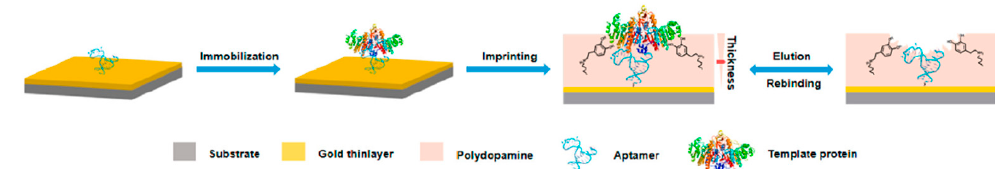
Figure 2. Schematic illustration of the principle and procedure for preparing aptamer–MIP hybrids. Reproduced with permission from [26]. Copyright American Chemical Society, 2019.